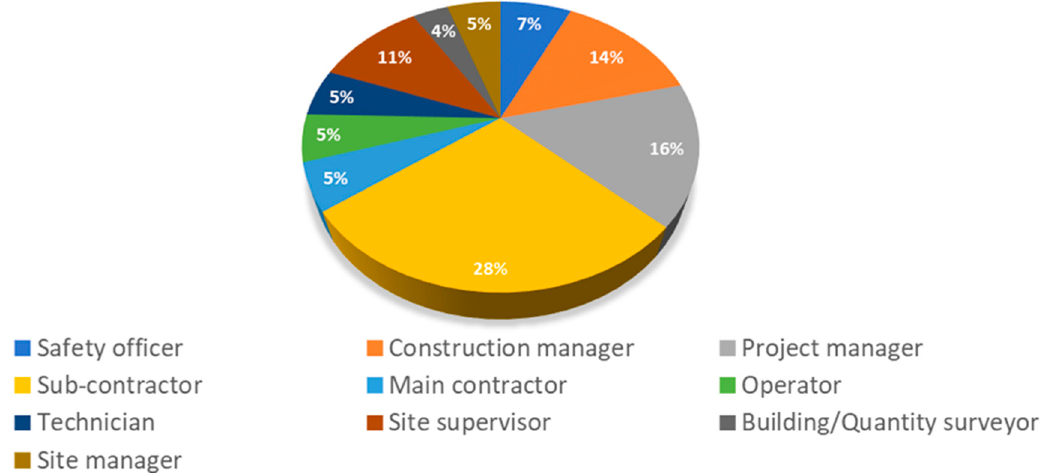
Figure 2. The breakdown of interviewed experts.